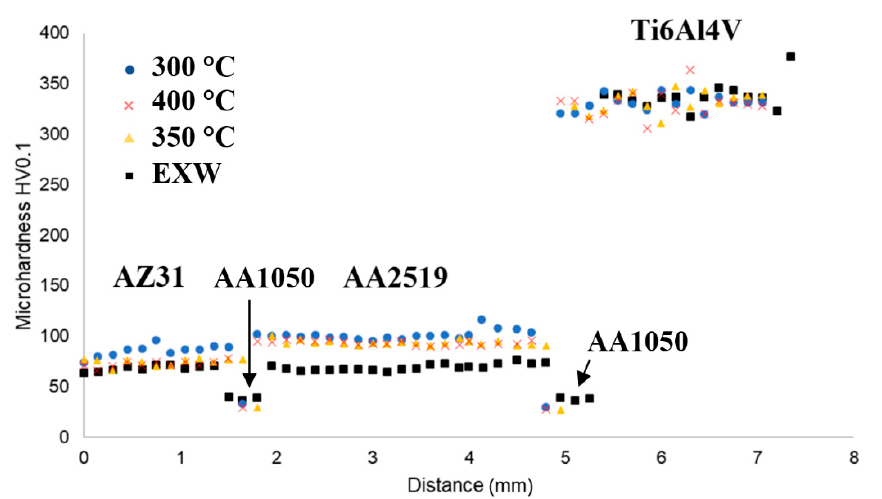
Figure 4. The distribution of microhardness in the investigated composite in the as-welded state (EXW) and after hot-rolling (300C, 350C, 400C).